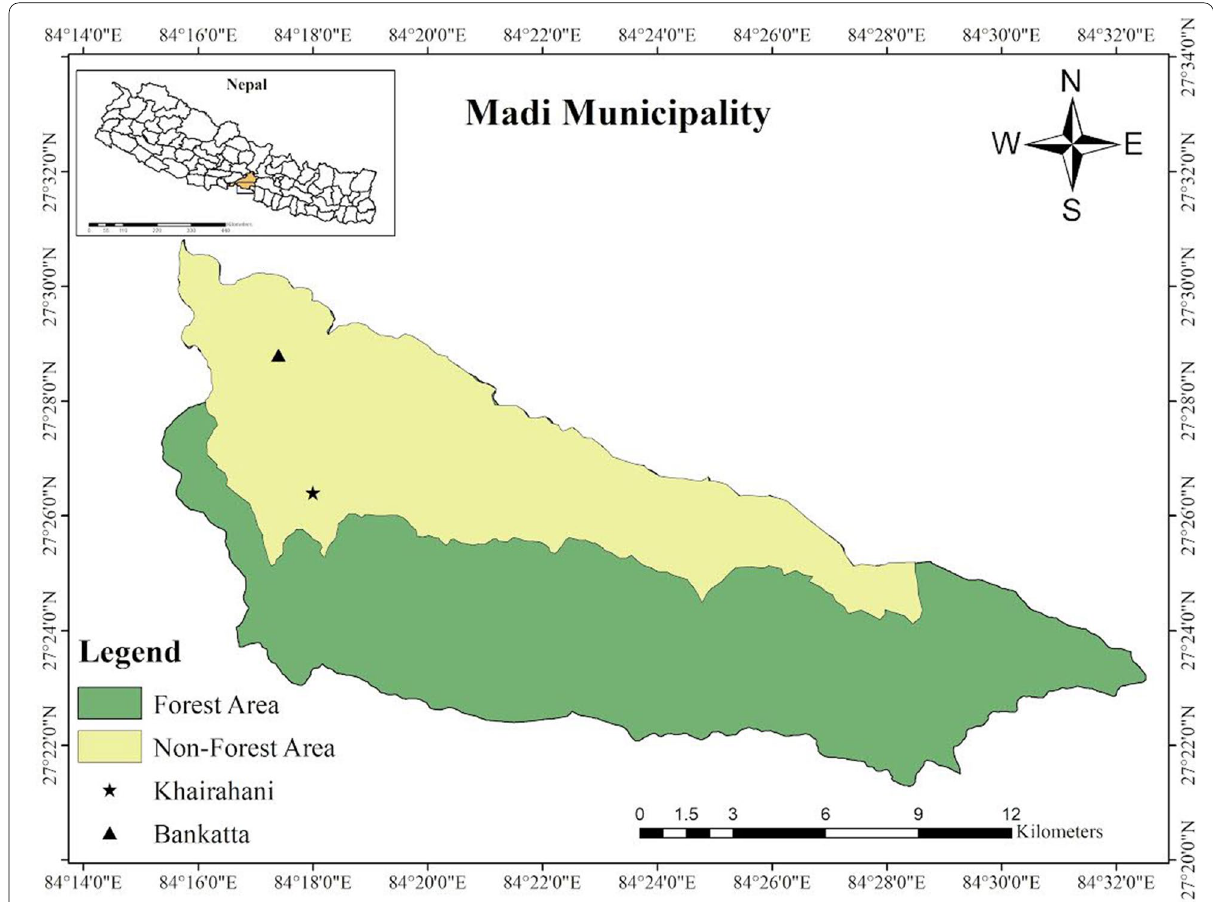
Fig. 1 Map showing the survey sites, namely Bankatta and Khairahani in Madi valley, Chitwan,